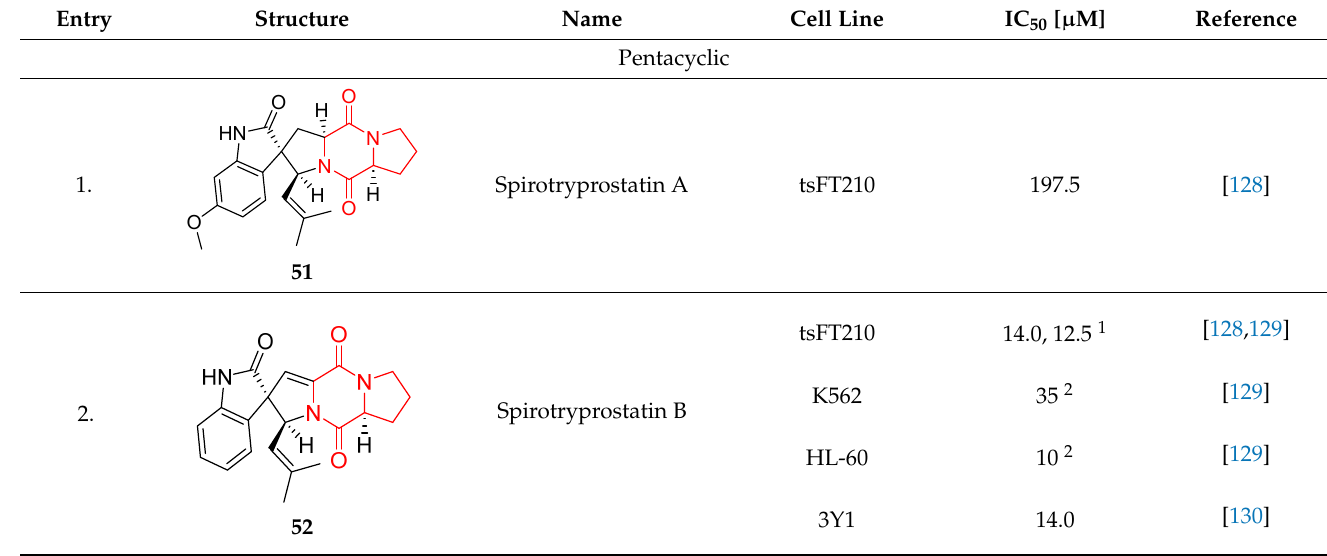
Table 4. Penta ‐ and hexacyclic proline ‐ based DKP.